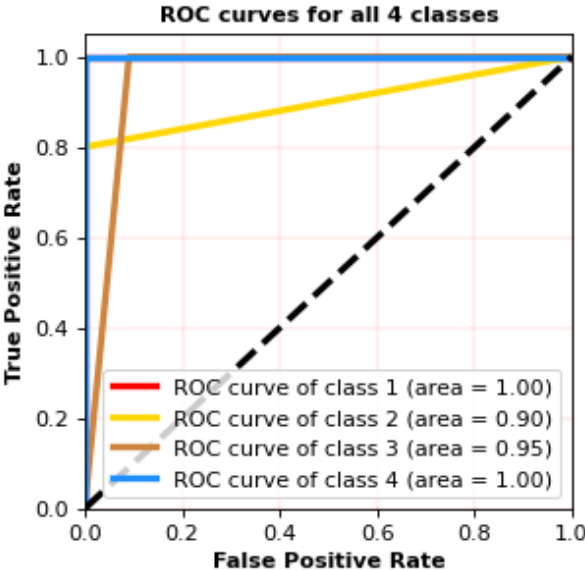
13 of 23 Figure 10. Real-World HAR: individual ROC curves for all the classes, class 1 = stairs-up, class 2 = stairs-down, class 3 = jumping, class 4 = lying, class 5 = running, class 6 = sitting, class 7 = standing, class 8 = walking. Figure 10 shows that the average area under the ROC curve was 0.95, which advo- cates SSRDC system’s performance over that of Real-World HAR. According to Figure 10, the smallest area was covered by “stairs-down”, i.e., 0.67, and the largest covered area, 1.00, was achieved by the “jumping”, “lying”, “sitting”, “standing”, and “walking” clas-